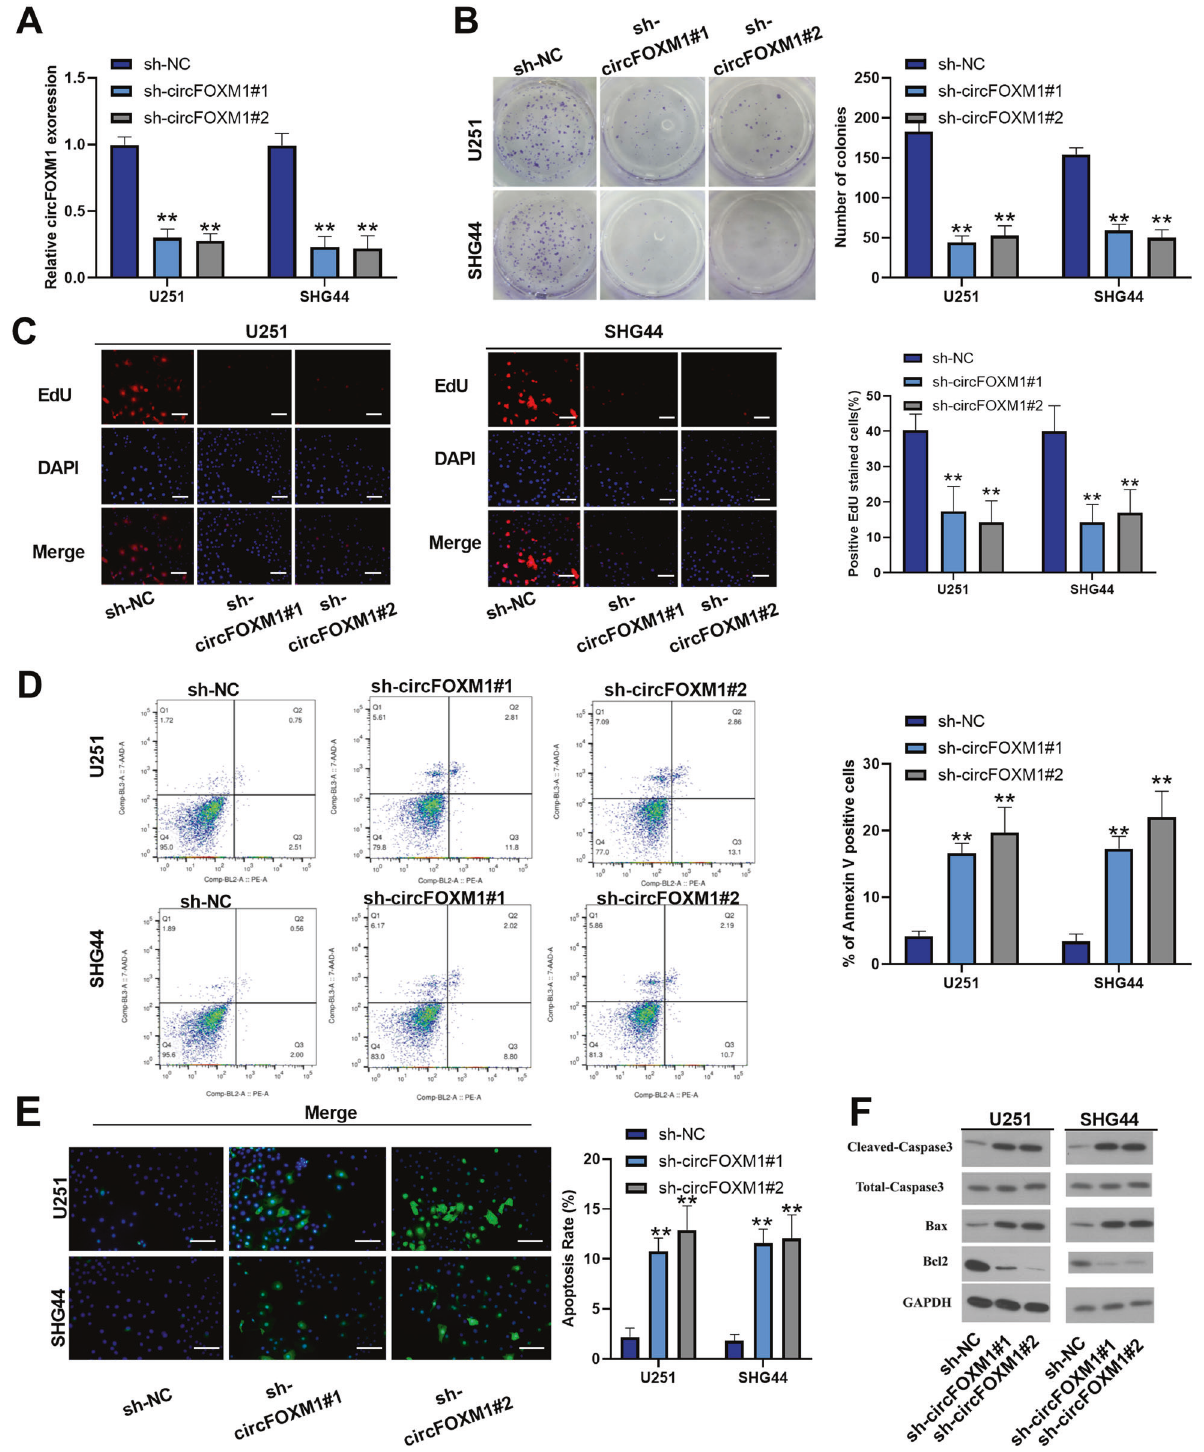
Fig. 2 circFOXM1 promotes glioma-cell progression in vitro. A The two designed siRNAs sh-circFOXM1#1 and #2 decreased the expression of circFoxM1, demonstrating targeting ef fi cacy. B , C The proliferation of glioma cells was detected by colony formation and EdU assays in response to knockdown of circFOXM1. D , E Apoptosis of glioma detected by fl ow cytometry analysis and TUNEL assay. F Western blot was used to measure the expression of apoptosis-related proteins in glioma cells with or without circFOXM1 silencing (** P < 0.01) (scale bar = 100 μ